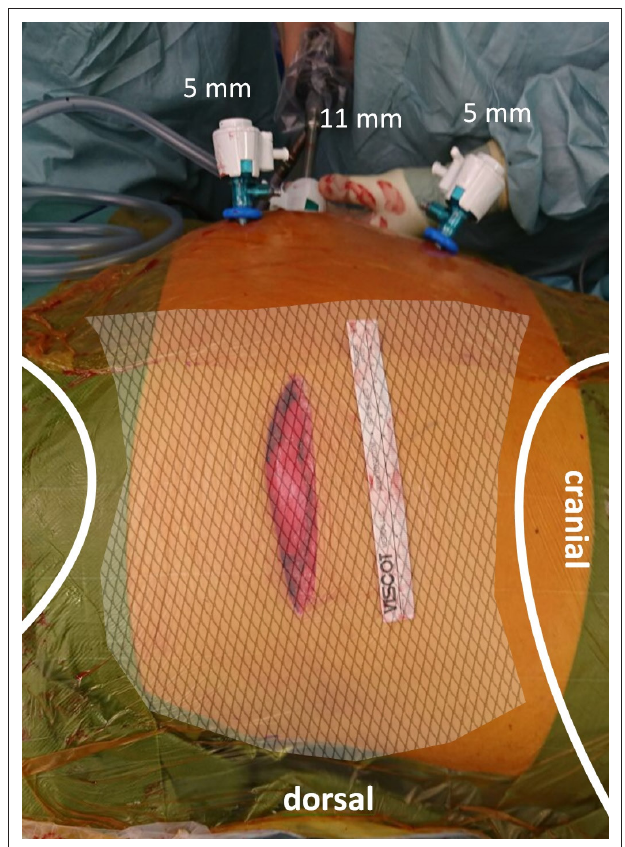
FIgure 5 | “Mini-open” skin incision before wound closure. The mesh has been placed in sublay position with a sufficient overlap in all directions.